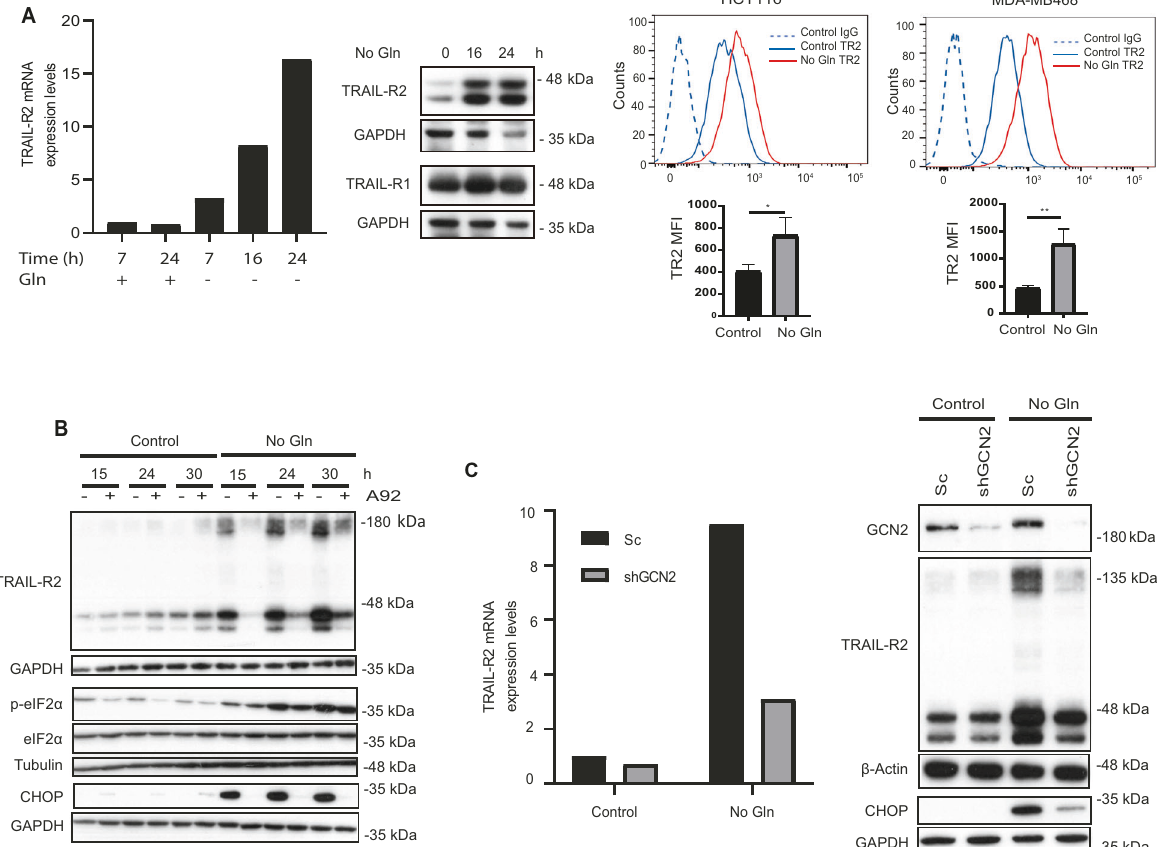
Fig. 3 GCN2-dependent TRAIL-R2 upregulation upon glutamine deprivation in tumor cells. A HCT116 cells were cultured in the presence or absence of glutamine for the indicated times and TRAIL-R2 mRNA levels were measured by RT-qPCR (left panel). TRAIL-R2 and TRAIL-R1 protein levels were assessed by Western blotting (middle panel). GAPDH was used as protein-loading control. Cell surface TRAIL-R2 levels (right panel) were also analyzed in HCT116 and MDA-MB468 cell lines after 24 h of glutamine deprivation in the presence of 20 µM Q-VD-OPh, as described in Materials and Methods (MFI: geometric mean fl uorescent intensity). B HCT116 cells were incubated for the indicated times in medium with or without glutamine, in the presence or absence of 1 µM A92. Western blotting was performed to determine TRAIL-R2, p-eIF2 α , eIF2 α and CHOP levels. C HCT116 cells stably expressing either a scrambled (Sc) or a GCN2 targeting sequence (shGCN2), were incubated for 17 h in the presence or absence of glutamine. Following this incubation, TRAIL-R2 mRNA levels were measured by RT-qPCR (left panel) and GCN2, CHOP and TRAIL-R2 protein levels were assessed by Western blotting (right